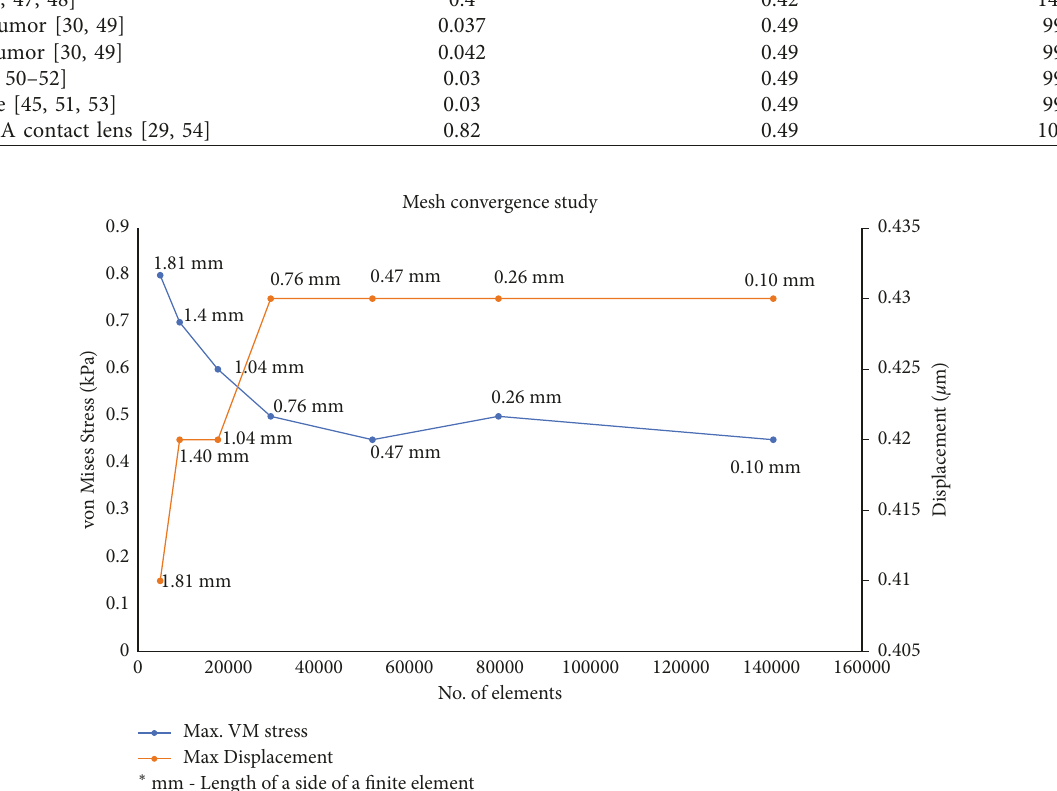
Figure 2: Mesh convergence study: proper number of finite elements. Graph drawn with Microsoft Excel 2019 (https://www.microsoft.com/